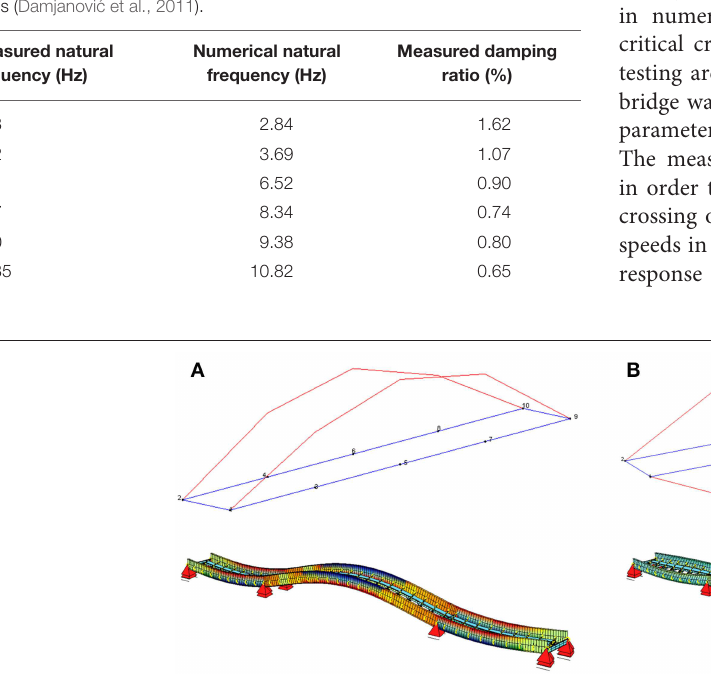
Frontiers in Built Environment |